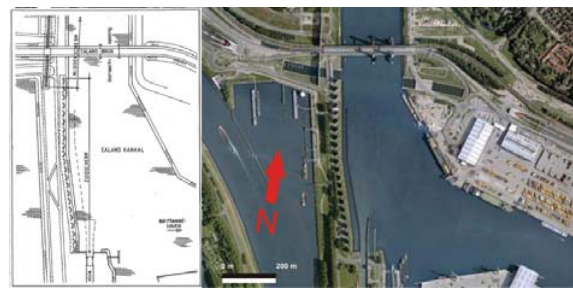
Fig. 6. Windscreen Calandkanaal – Th e Port